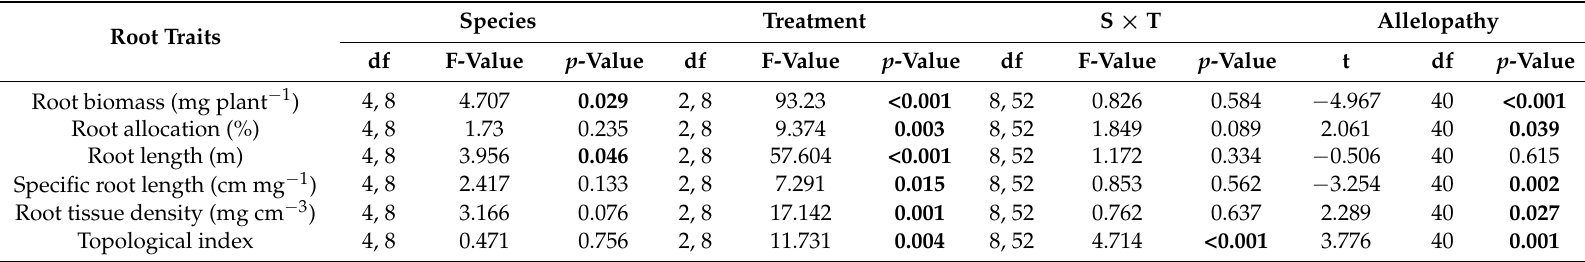
Table 1. Summary of the effects of species, treatment (monoculture, mixed with nonallelopathic rice or mixed with allelopathic rice) and their interactions on root biomass and allocation and root morphological traits of E. crus-galli according to linear mixed models. The effects of rice allelopathy on barnyardgrass root biomass and allocation and root morphological traits according to t -test. The significant effects ( p < 0.05) are shown in